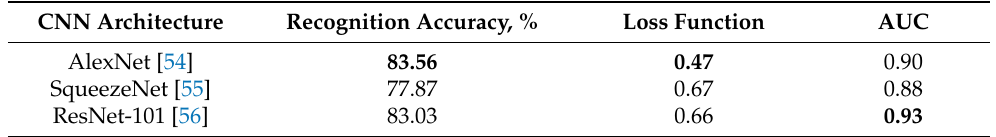
Table 5. Testing results of the proposed multimodal neural network system to recognize pigmented lesions. Bold font indicates the best result in each column of the